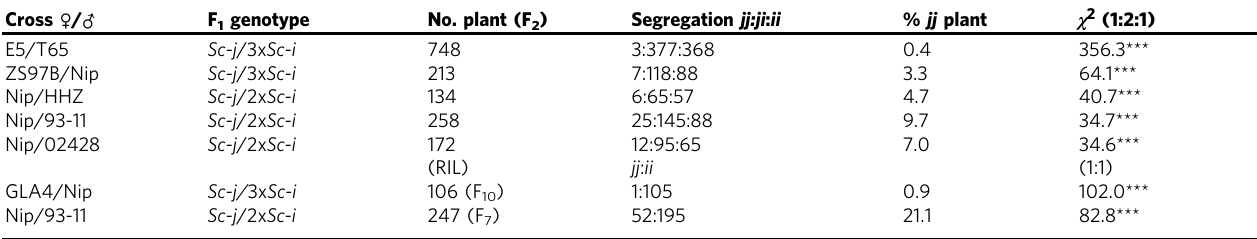
Table 1 Segregation distortion in various crosses using indica parents with different copy numbers of Sc-i Cross ♀ / ♂ F 1